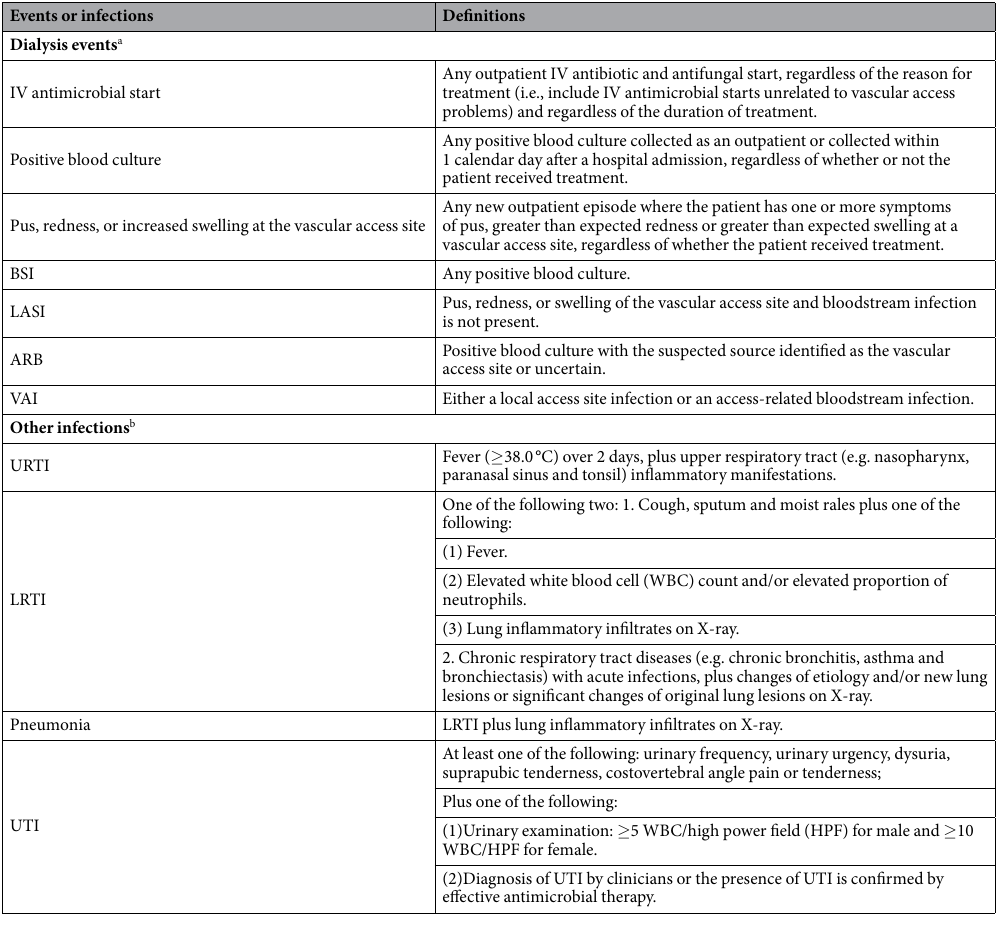
Table 1. Definitions of dialysis events and other infections. a The definitions are from the NHSN Dialysis Event Protocol 14 . b The definitions are from the standards by the Chinese Ministry of Health 15